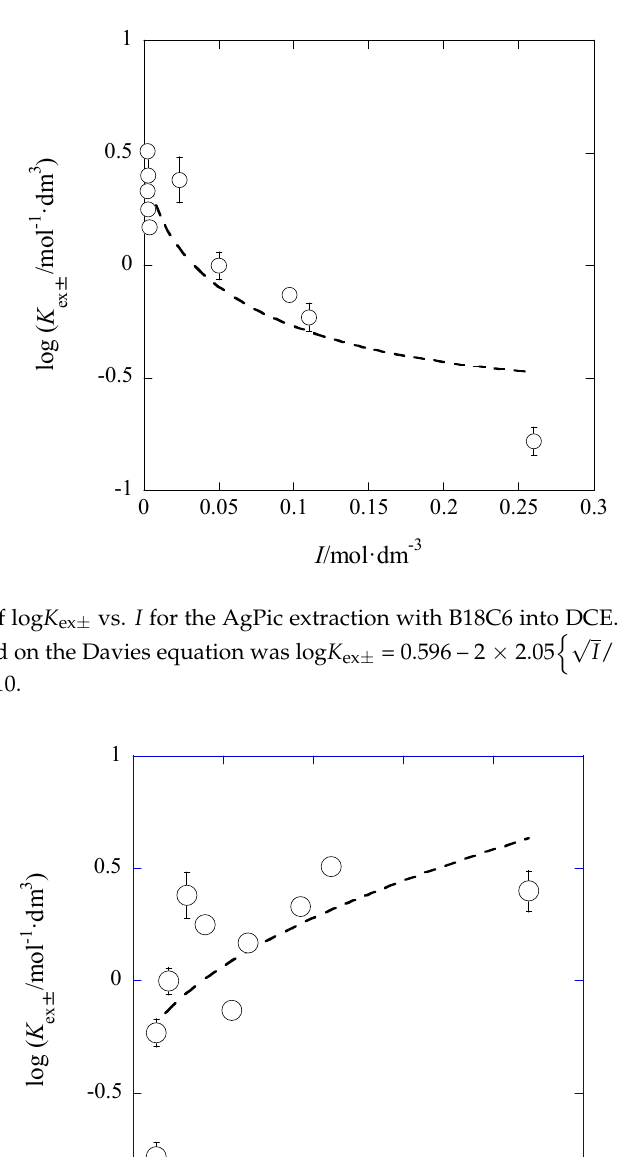
Figure 7. A plot of log K ex± vs. I DCE for the AgPic extraction with B18C6 into DCE. See the text for the regression line (broken line).